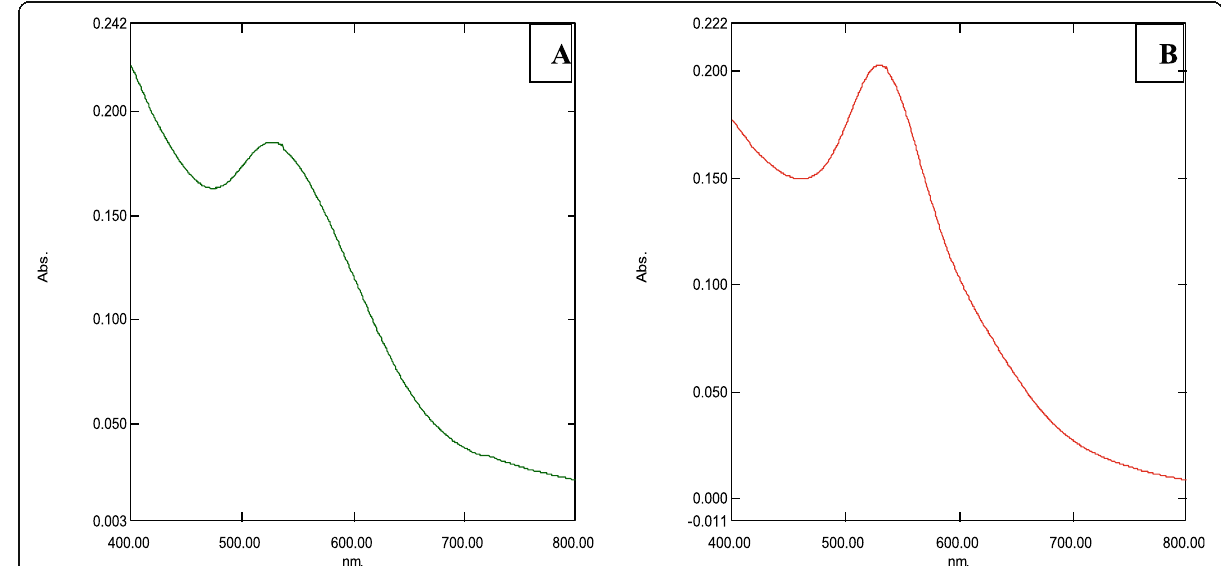
Fig. 2 a , b : UV-visible absorbance spectrum of AuNPs synthesized with CIL ( ƛ max -529 nm) & CIF ( ƛ max -525 nm) . The peak between 500-600 nm confirms the formation of